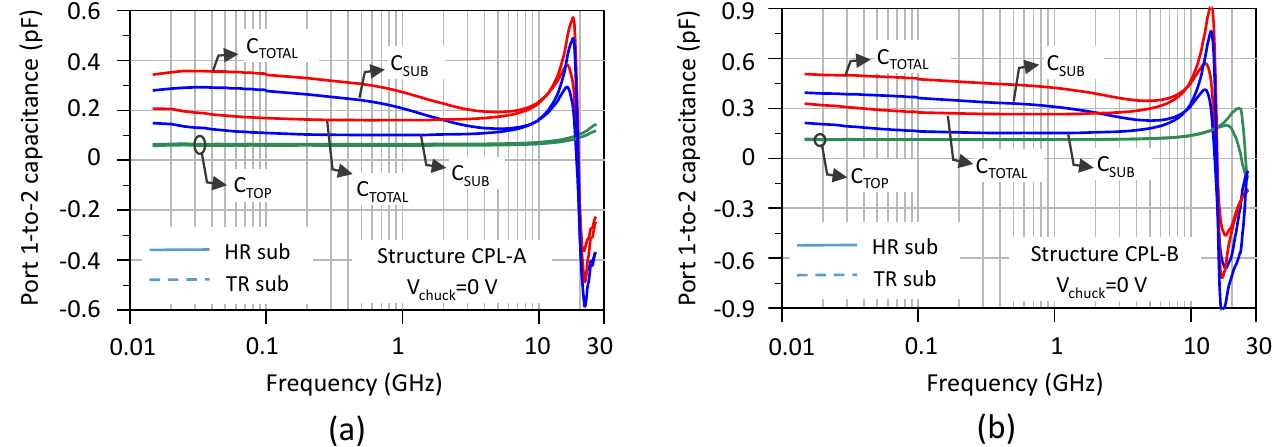
Figure 5. Coupling capacitance between the electrode combs. C TOTAL is the total measured capacitance, C TOP is the capacitance mainly associated with the interconnects, C SUB represents the contribution of the substrate to the lateral capacitive coupling. ( a ) Structure CPL-A; ( b ) structure CPL-B.